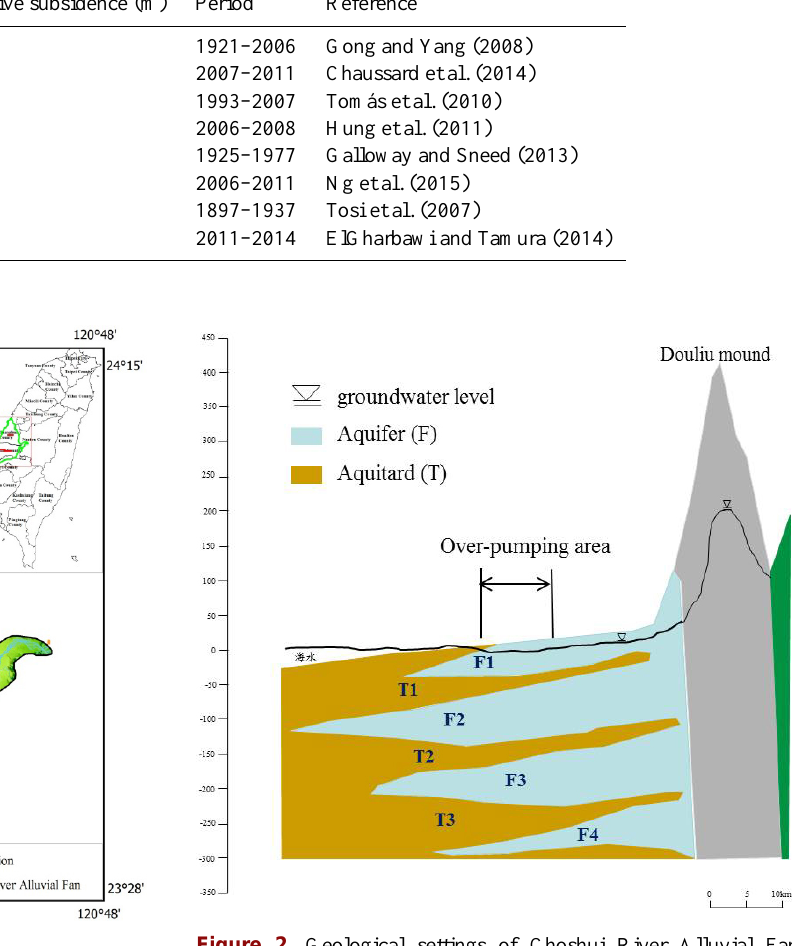
Figure 1. Geographical location of Choushui River Alluvial Fan (CRAF).